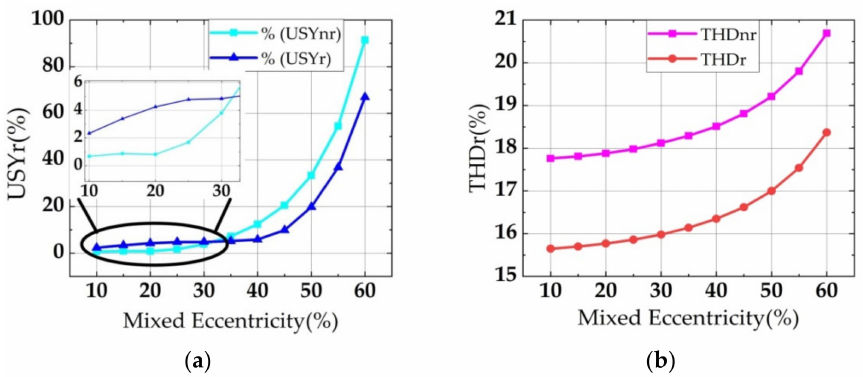
Figure 10. The influence of the bridge saturation on USYnr and THDnr : ( a ) USYn ; ( b ) THDnr